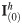
Various possible arrangements of varying sizes of non-compliant blocks.The shading within a particular configuration indicates the distributions of the unperturbed eigenvectors I(0)h and I(0)v as determined by first order perturbation analysis when that configuration is the unique configuration which determines δR0 in a neighborhood, assuming ξ = 1.5 and that the pictured blocks are not part of the neighborhood boundary. Any configuration of size one through six can be obtained from one of the pictured configurations through a number of bending symmetry operations.